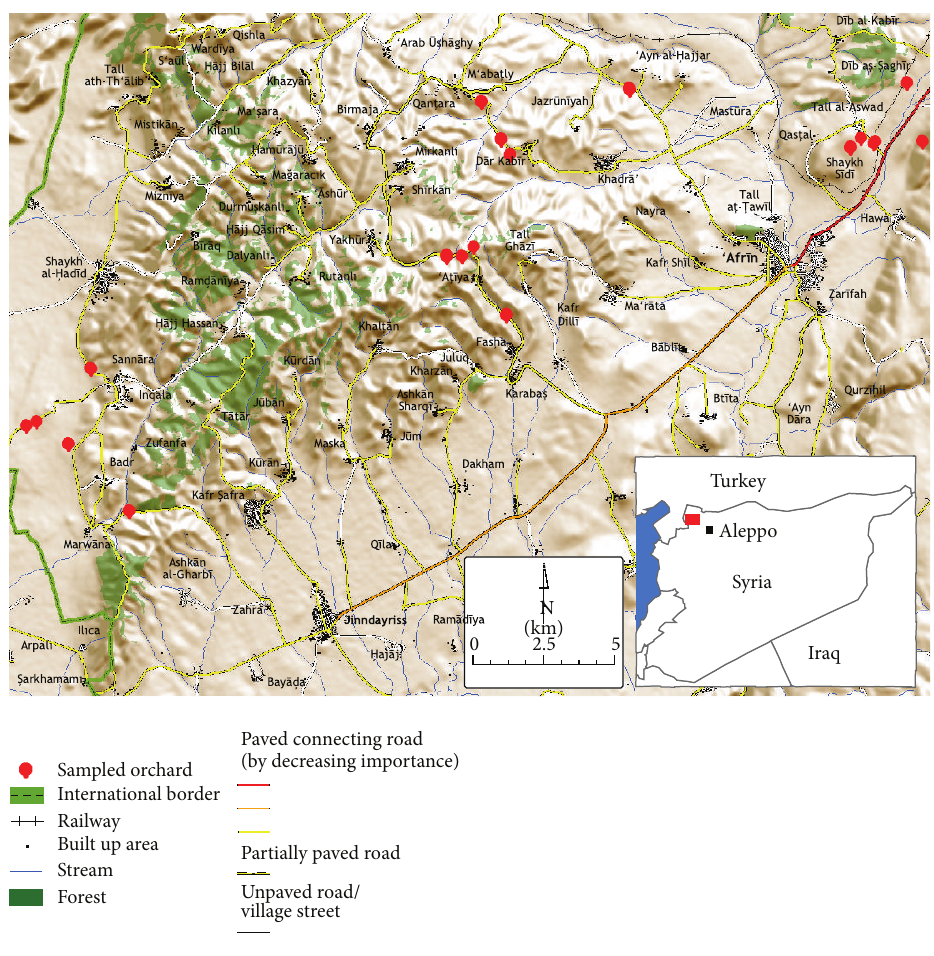
Figure 1: A topography map of northwestern Aleppo Governorate showing Afrin area with the orchard locations (red dots).